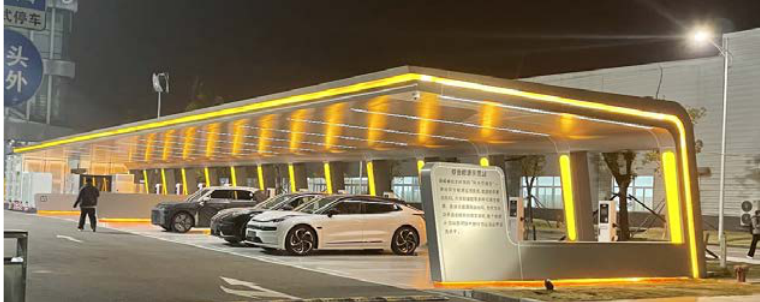
Fig. 9. Actual operation at